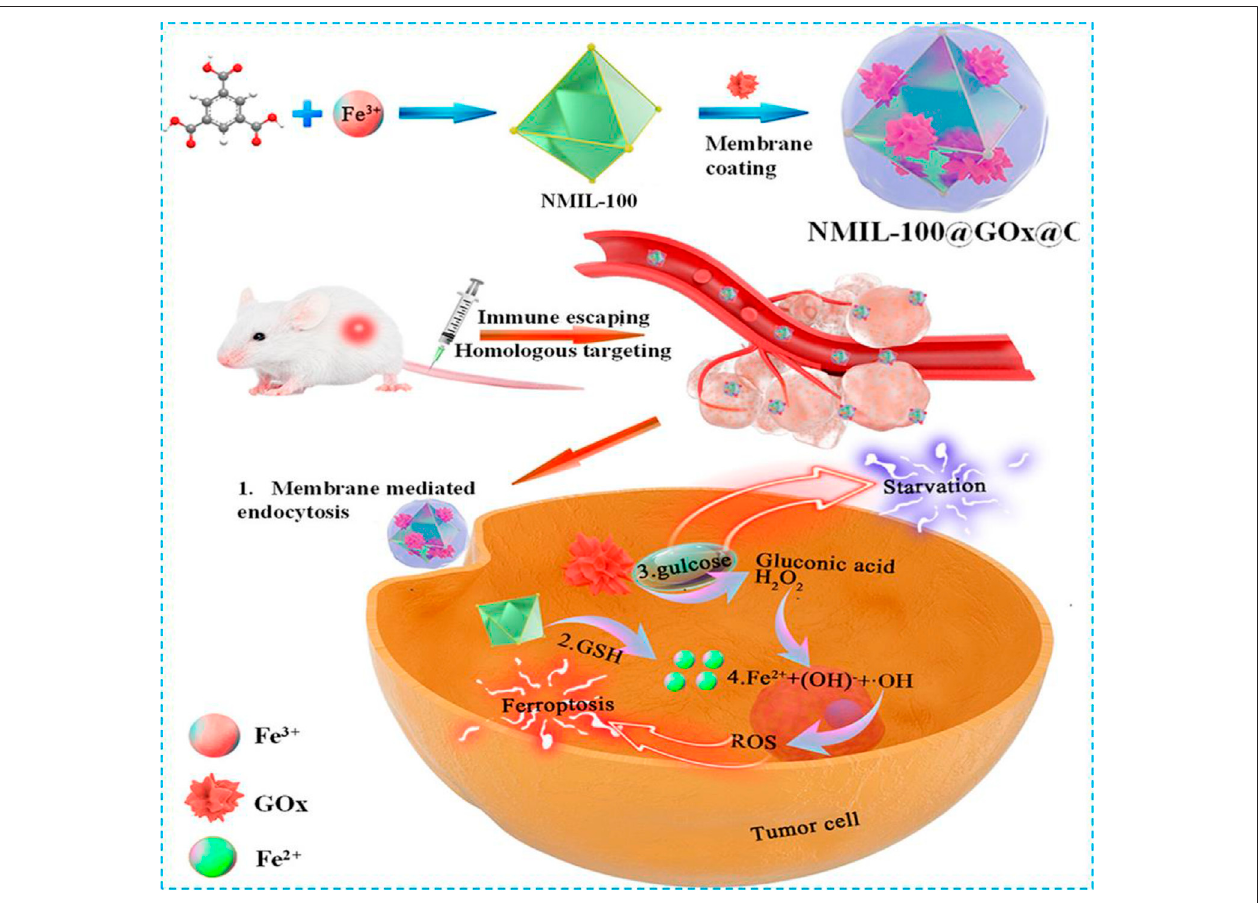
FIGURE3| Schematic illustration ofthe preparation and cascade processes for cancer therapyofNMIL-100@GOx@C.Reprinted with permission from Ref.(Wan et al., 2020). Copyright 2020 American Chemical Society.